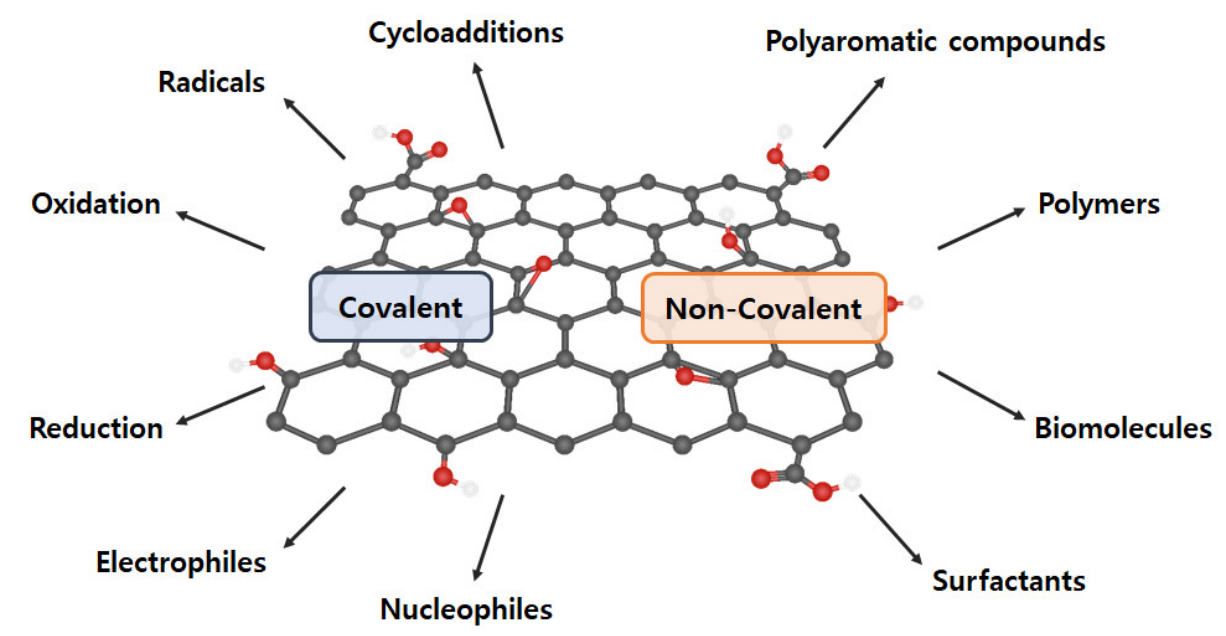
Figure 4. Various covalent and non-covalent graphene functionalization.